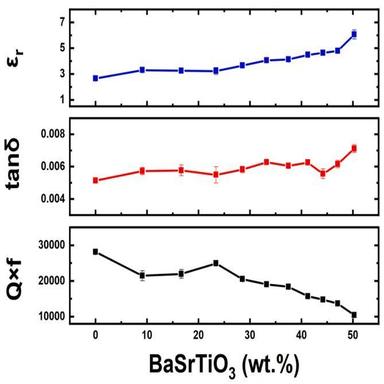
BST/ABS Mass Fraction vs. Relative Permittivity (εr), Dielectric Loss (tanδ) and Quality Factor (Q×f) of the 3D printed test samples, measured at 5 GHz using the SPDR.